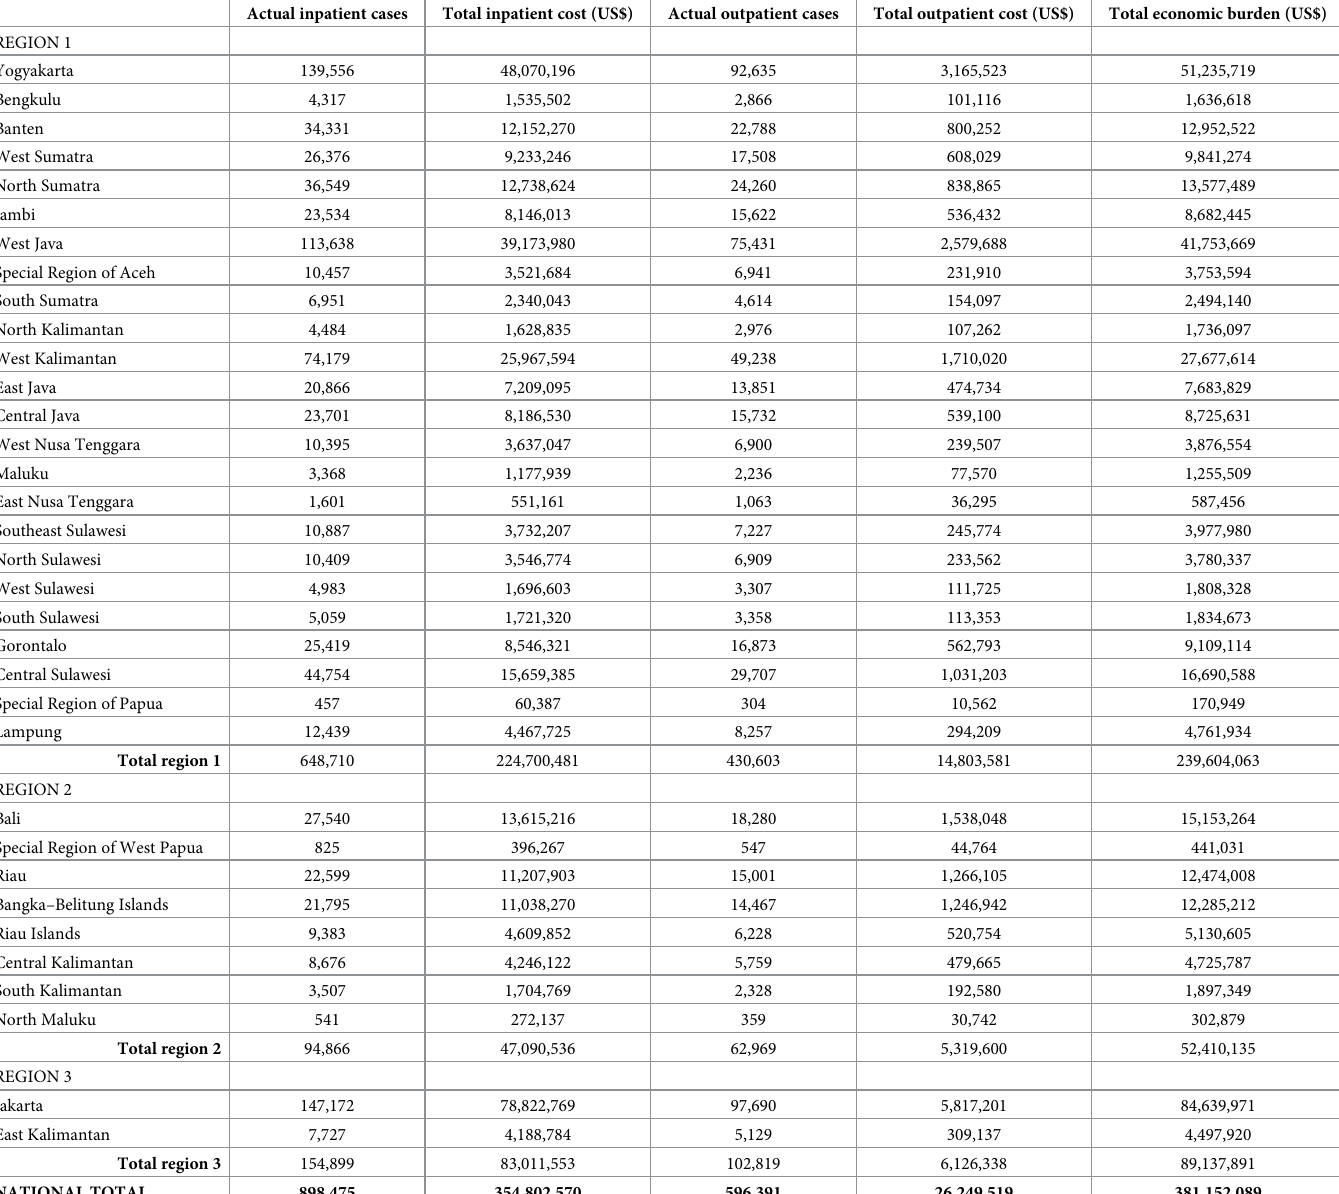
Table 3. Extrapolated total economic burden (in US$) of dengue in Indonesian provinces by income-category (Region 1: Low income context, Region 2: Medium income context, Region 3: High-income context). Number of cases estimated by extrapolation from cases reported from passive surveillance in 2015 using expansion